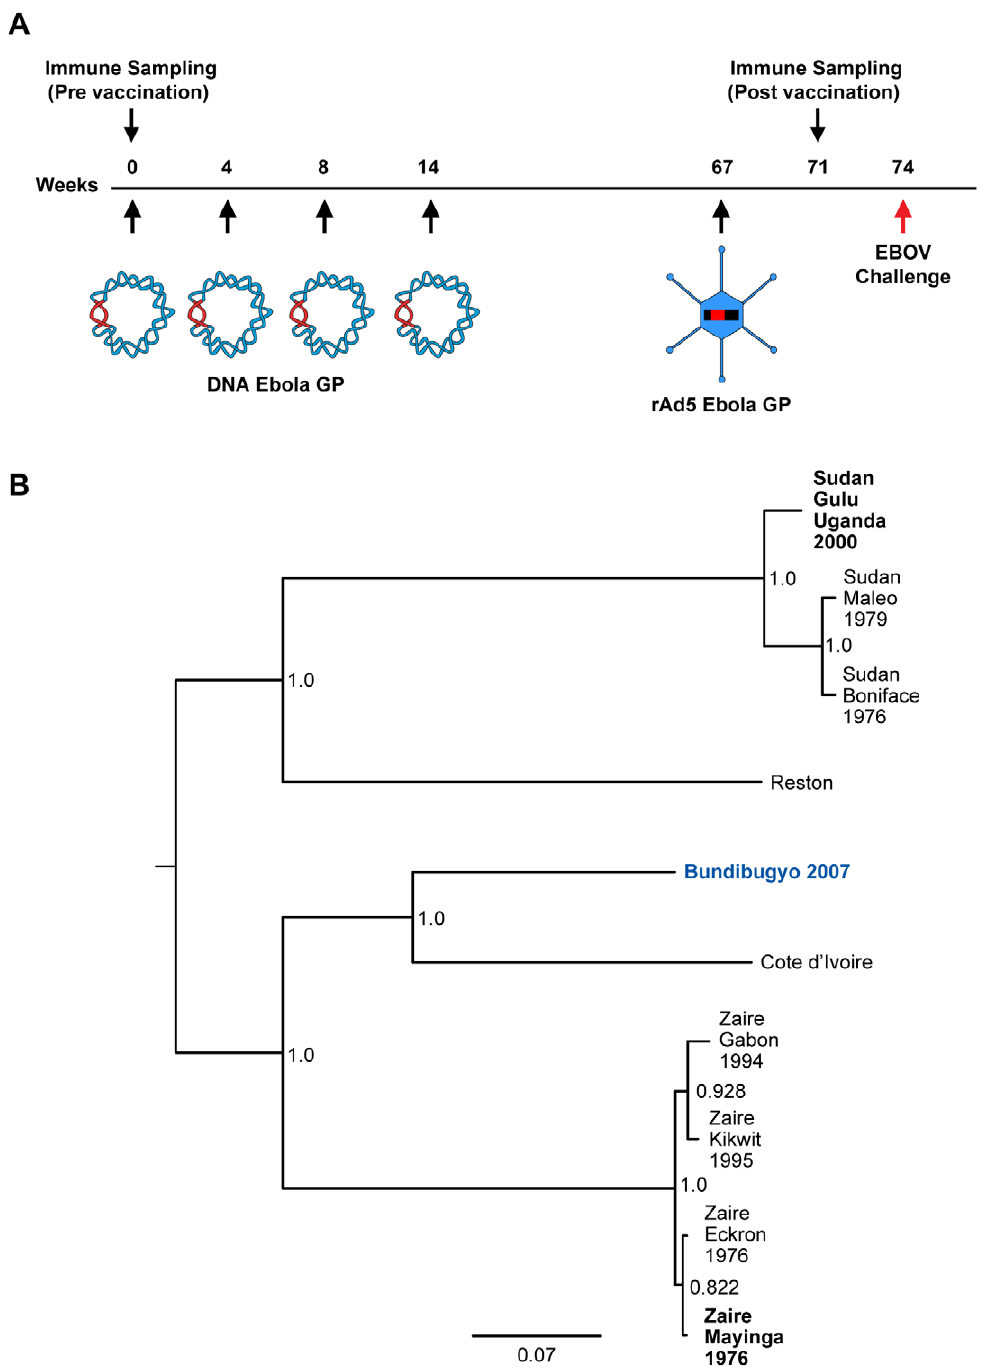
Figure 1. Vaccination and challenge schedule. (A) Vaccine group NHP were injected with plasmid DNA and rAd5 vectors encoding GP from SEBOV and/or ZEBOV. Individual DNA immunizations were spaced by 4–6 week intervals and the rAd boost was given one year after the final DNA prime. Animals were exposed to a lethal dose of BEBOV 7 weeks after the rAd5 GP boost. (B) Distance matrix-based phylogenetic tree for EBOV GP. Numbers at the nodes are boostrap percentages. Vertical branches are for graphic representation; horizontal branch lengths are measured as substitutions per site (scale bar =0.07). The infectious challenge species is shown in blue. Vaccine strains are indicated in bold. doi:10.1371/journal.ppat.1000904.g001 (Figure 3B). The magnitude of antigen-specific CD4 + T cells was species specificity demonstrated for antibody responses in this uniform across the four immunized macaques and exceeded that study, CD4 + T cells elicited by the vaccine gene inserts were cross- reactive with BEBOV GP. Intracellular cytokine secretion was observed with a single-shot rAd vaccine [5,12,18,19,20,21], stimulated by BEBOV GP in each of the vaccinated macaques, demonstrating the potency of DNA priming for augmentation of suggesting that dominant T-cell epitopes are contained within the CD4 + T cell immunity seen by others [18]. In contrast to the